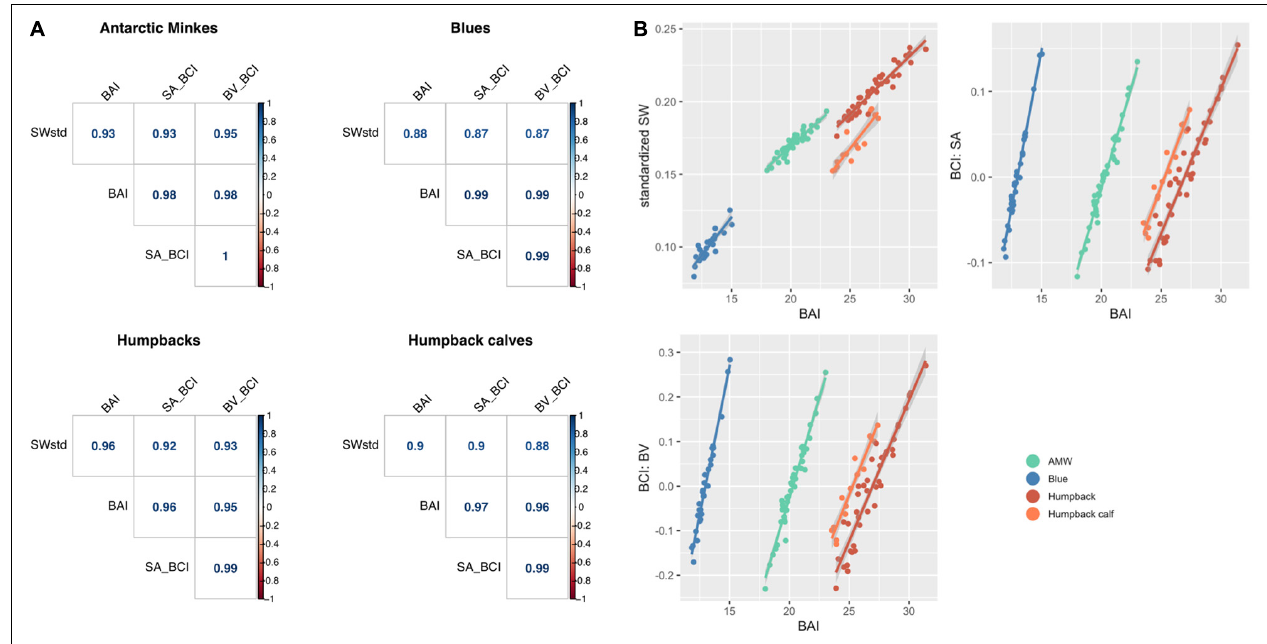
FIGURE 7 | (A) Correlogram (graph of correlation matrix) comparing each standardized metric for each species. SW std , standardized single width (Eq. 11); SA_BCI, BCI SA (Eq. 17); BV_BCI, BCI BV (Eq.18); BAI, body area index (Eq. 14). (B) Regression between BAI and each standardized metric. BAI is highly correlated with each standardized metric, with Pearson’s correlation coefficient r > 0.88 for each